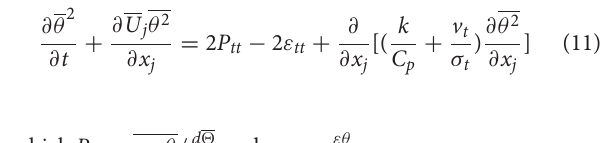
Table 1 . The optimized coefficient based on the simulation results obtained in section LES Simulations of Turbulent Channel Flow at Pr = 0.005 is also shown in Table 1 . An algebraic turbulent heat flux model has already been implemented in OpenFOAM by the authors and validated in previous numerical studies of supercritical fluid (Xiong and Cheng, 2014). It should be mentioned that a k- ω SST model is employed to predict turbulent viscosity in the current study (Menter et al., 2003).